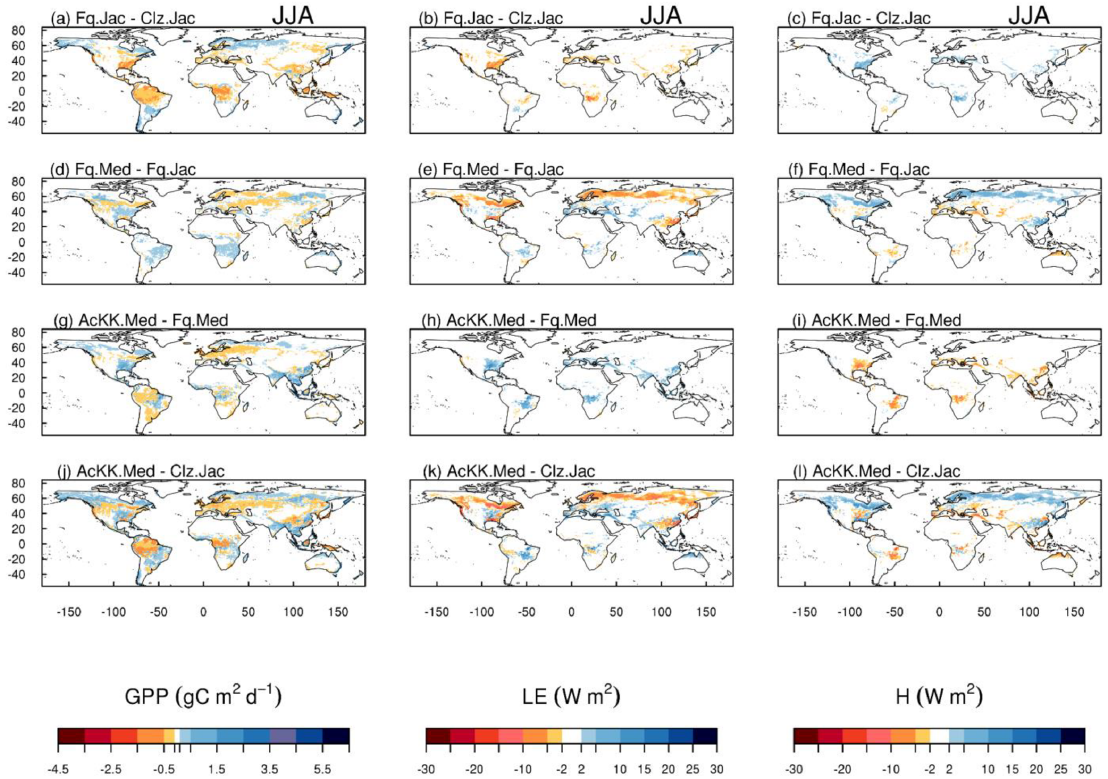
Figure 2. Absolute difference between JULES-modelled GPP, latent ( LE ) and sensible heat ( H ) for the different JULES model configurations in June–July–August (JJA) to show the impact of (a, b, c) changing photosynthesis scheme (Fq.Jac–Clz.Jac), (d, e, f) changing g s scheme (Fq.Med–Fq.Jac), (g, h, i) accounting for thermal acclimation of photosynthesis (AcKK.Med–Fq.Med) and (j, k, l) the overall change (AcKK.Med–Clz.Jac), under present-day meteorological conditions. For each variable, the mean over the period 2002 to 2012 is used. The absolute mean value simulated by each model configuration (JJA) is shown in Fig. S8. DJF is shown in Fig. S9 (mean absolute values) and Fig. S10 (absolute difference).